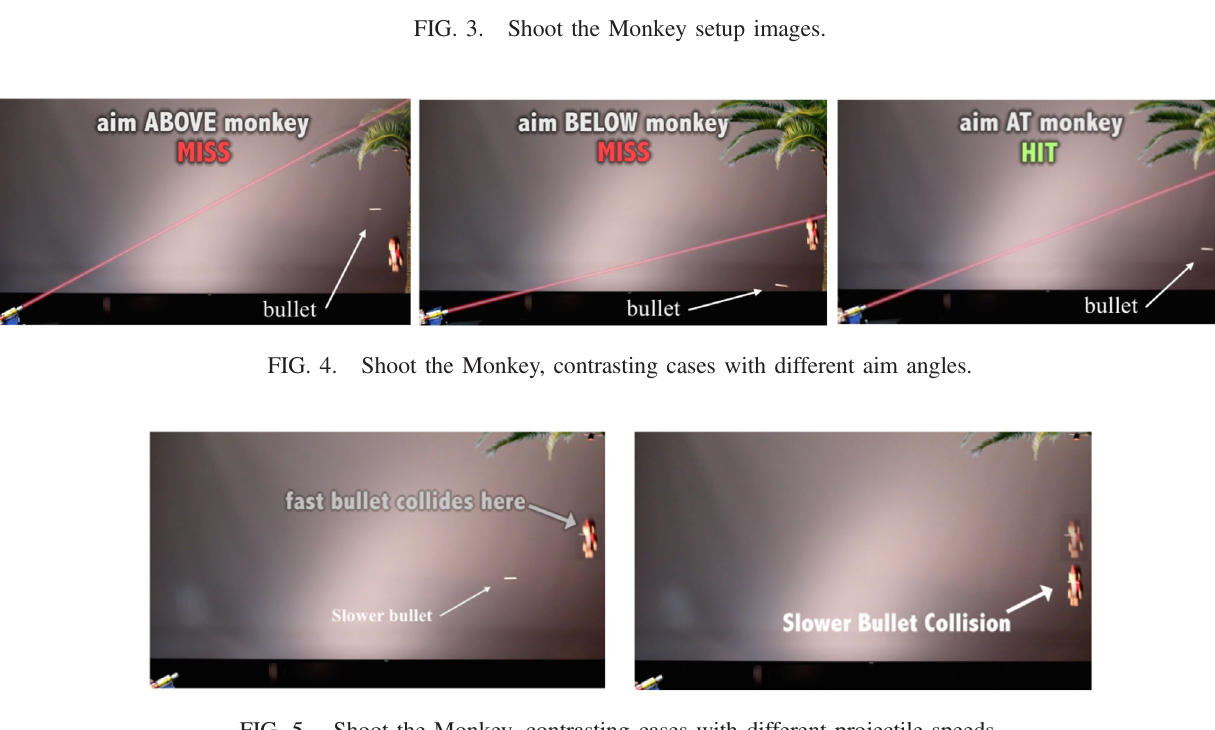
FIG. 5. Shoot the Monkey, contrasting cases with different projectile speeds.